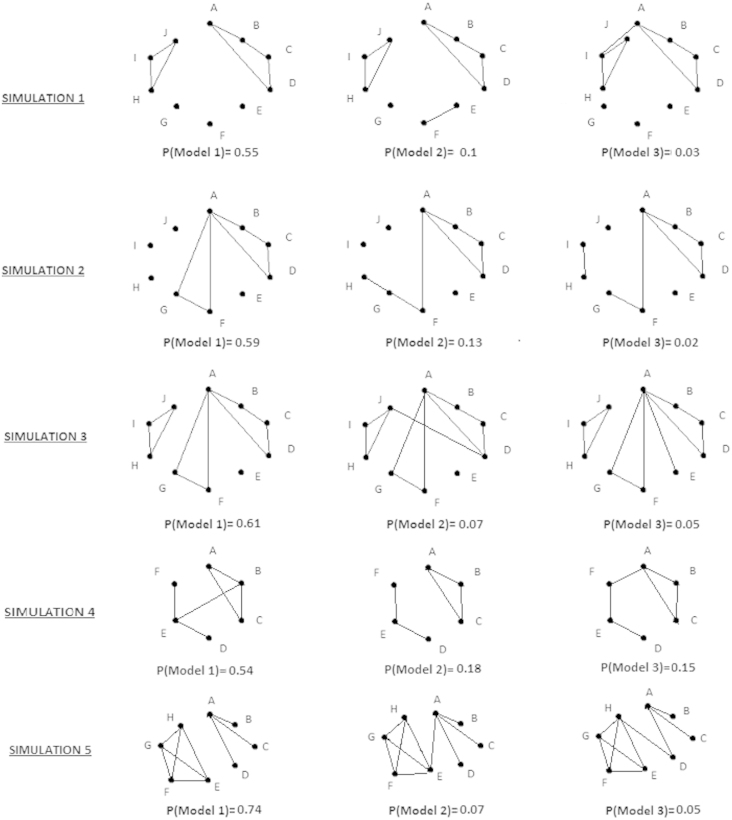
The resulting best models from the five simulations.